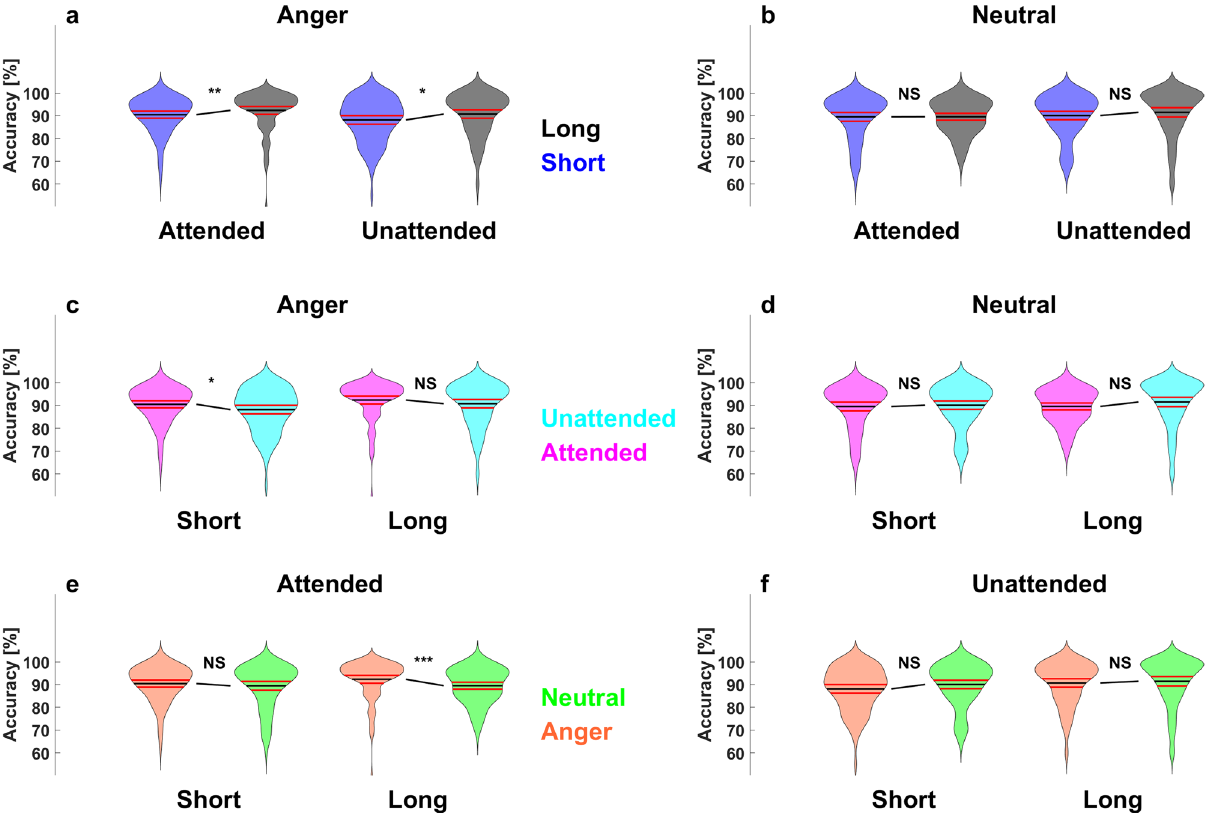
Figure 3. Emotional specific temporal attentional biases in emotional prosody perception in accuracy. Violin plots of accuracy depending on the factors cue, attention and emotion. Cues differences between short (in blue) and long (in grey) trials (Top), for angry voices left and for neutral voices right, depending on the attentional factor (attended and unattended; a – b ). Attentional differences between attended (in magenta) and unattended (in cyan) trials (Middle), for angry voices left and for neutral voices right, depending on the target stimulus onset factor (short and long; c – d ). Emotional differences between angry (in orange) and neutral voices (in green) trials (Bottom), for attended voices left and unattended voices right, depending on the target stimulus onset factor (short and long; e – f ). Note here that the raw results are presented in Table S1. Same color and display codes as in Fig.